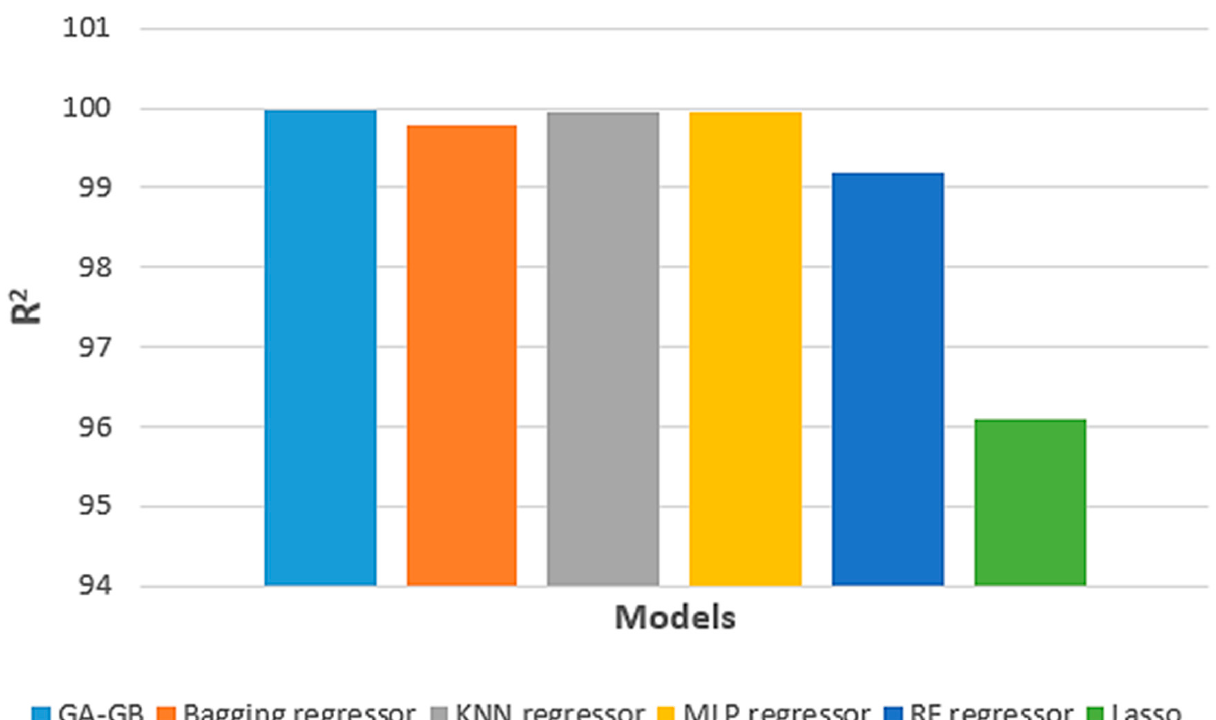
Figure 2. Comparison between the models used in the term of coefficient of determination (R 2 ) using OProd dataset.